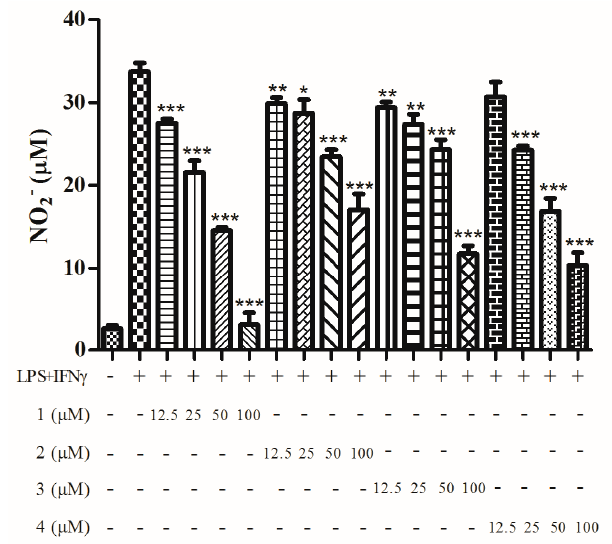
Figure 6. Effect of compounds 1 – 4 on inhibition of NO production stimulated by LPS and IFN- γ . The data were expressed as the means ± SD from four individual experiments and were analyzed using a t test to determine any significant differences. * p ď 0.05, ** p ď 0.01, *** p ď 0.001 compared to control group with LPS/IFN- γ